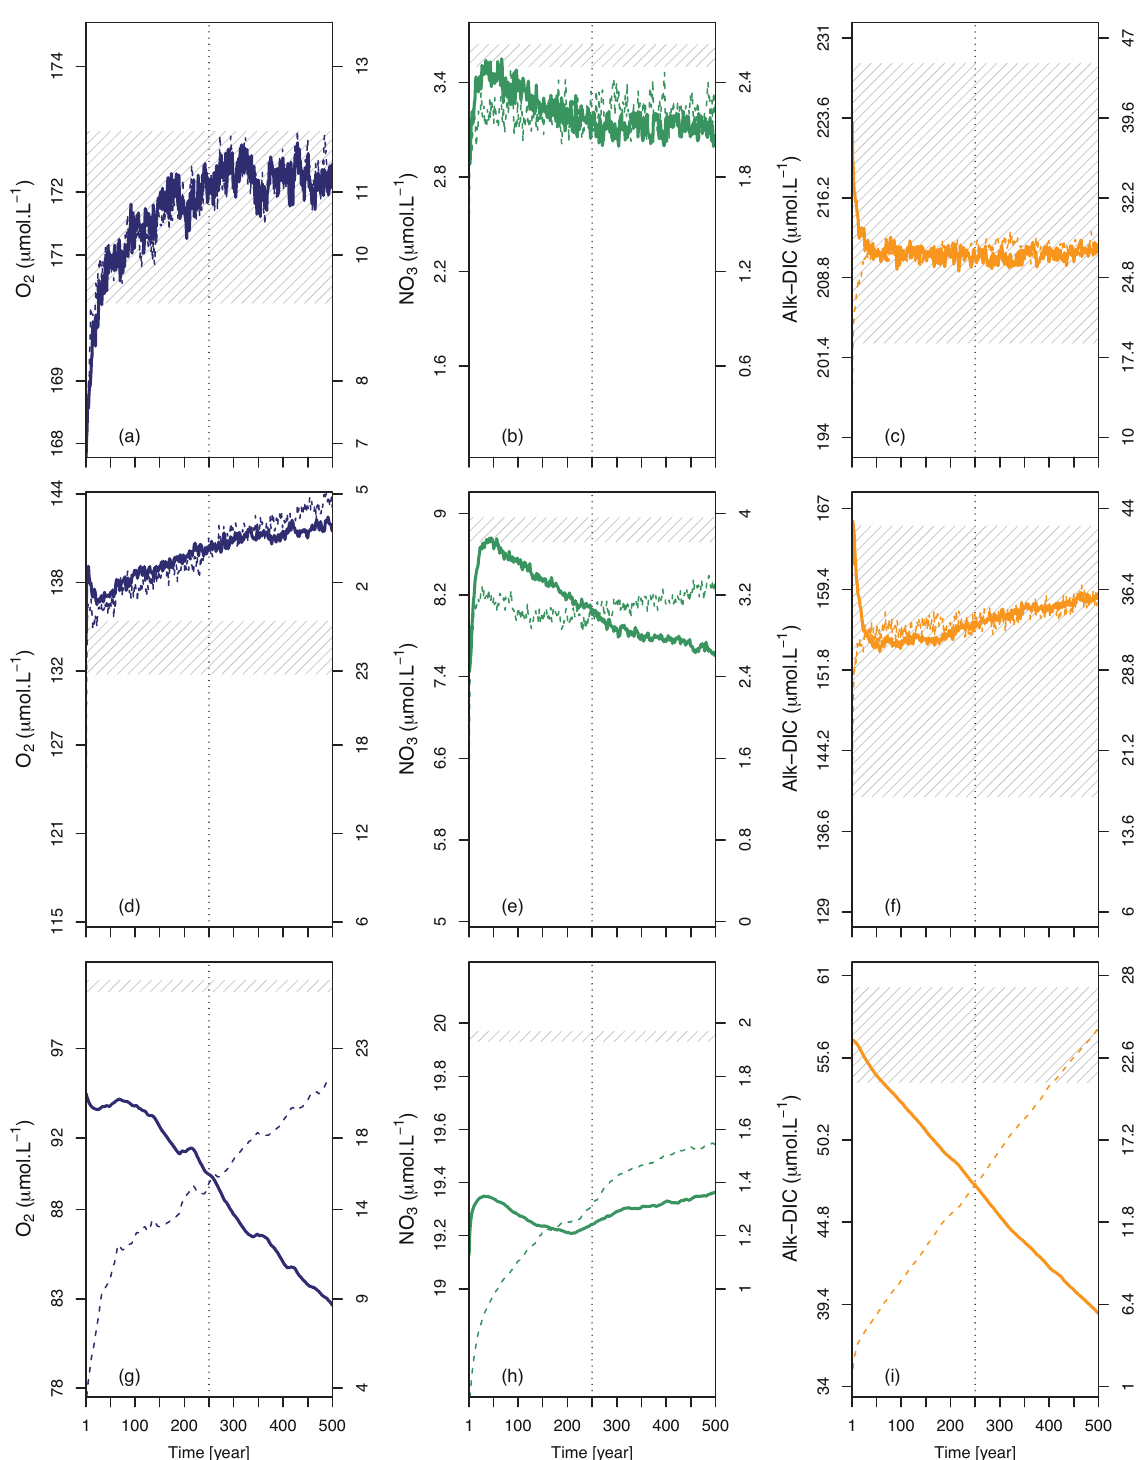
Figure 3. Time series of globally averaged concentration (in solid lines) and globally averaged root-mean squared error (RMSE in dashed lines) for dissolved oxygen (O 2 ), nitrate (NO 3 ) and difference between alkalinity and dissolved inorganic carbon (Alk-DIC) as simulated by IPSL-CM5A-LR. Globally averaged concentration and RMSE are given at surface (a, b, c) , 150m (d, e, f) , and 2000m (g, h, i) for these three biogeochemical fields. Their values are indicated on the left-side and right-side y axis, respectively. Hatching represents the ± σ observational uncertainty due to optimal interpolation of in situ concentrations around the observed globally averaged